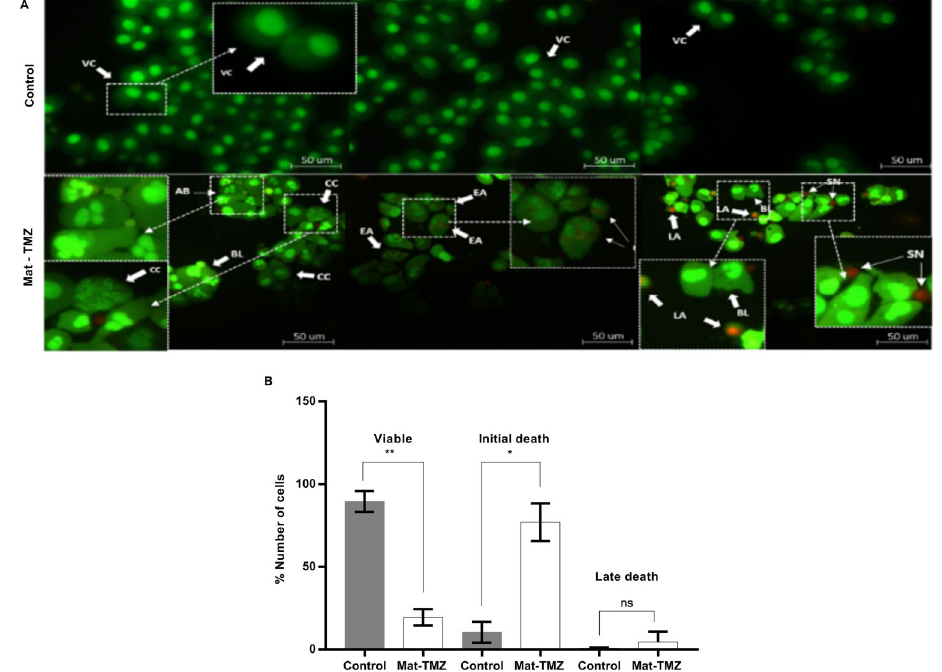
Figure 3. A , Fluorescence morphological assay using acridine orange and propidium iodide in U251 cell line after treatment with matteucinol-temozolomide (Mat-TMZ) (28 m g/mL Mat and 9.71 m g/mL TMZ). The assay was performed in experimental duplicates and two independent experiments. The negative control was 1% DMSO. B , Number of viable and dead cells in the U251 cell line. Data are reported as means ± SD. *P=0.0185; **P=0.0066 (Student ’ s t -test). ns: not signi fi cant. VC: viable cells; EA: early apoptotic cells; CC: chromatin condensation; BL: cell membrane blubbing; AB: apoptotic body; LA: late apoptotic cells; SN: secondary necrotic cell.